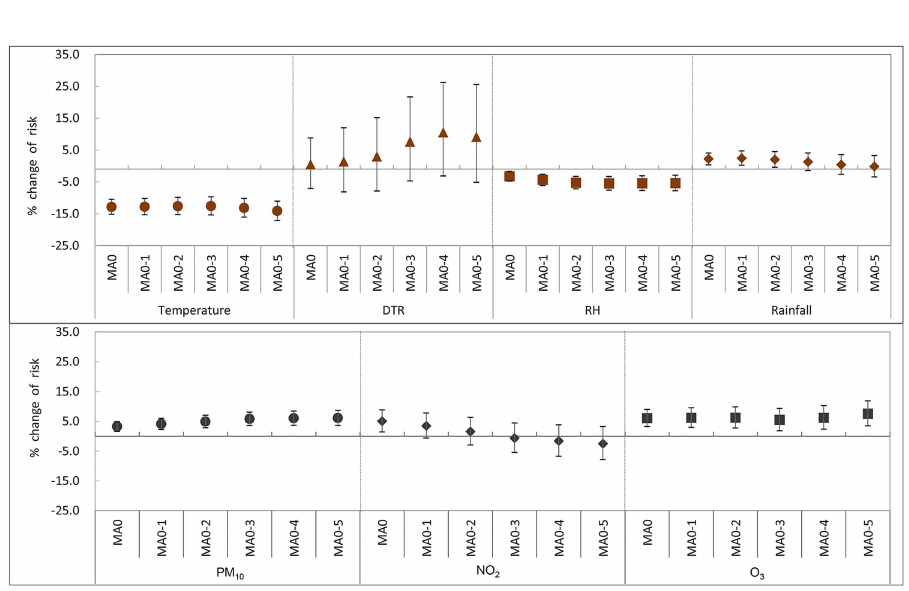
Fig 2. Effects of meteorological variables and air pollution on Atopic Dermatitis(AD) symptoms by moving average. Data represent percent changesand 95% confidenceintervals in AD symptoms per 5-unit increasein daily mean temperature(˚C), relativehumidity (%), diurnal temperature range (˚C) and 10-unit increasein PM 10 ( μ g/m 3 ), NO 2 (ppb), and O 3 (ppb). RH: relative humidity; DTR: diurnal temperature range; MA: moving average.